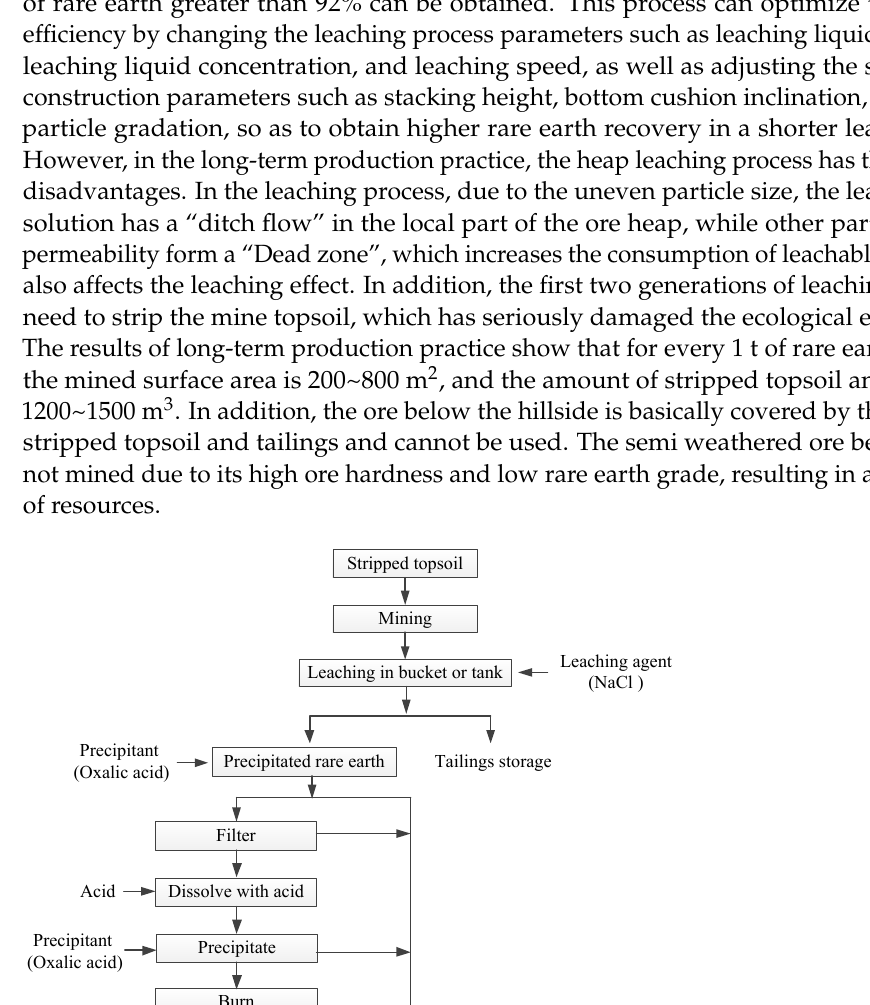
Figure 5. First generation leaching extraction process.